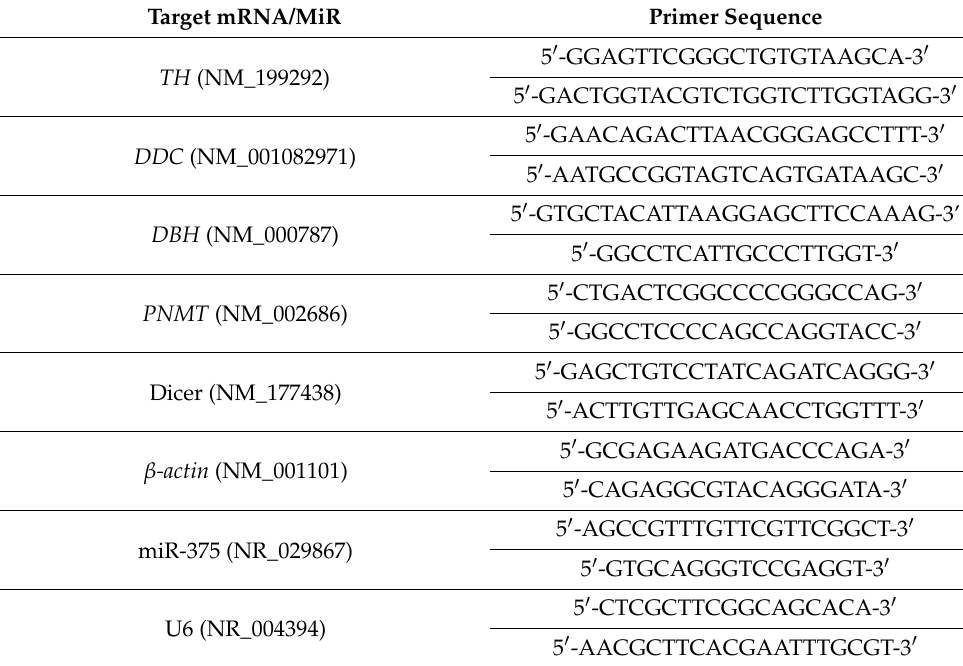
Table 2. PCR primers (human) for the real-time